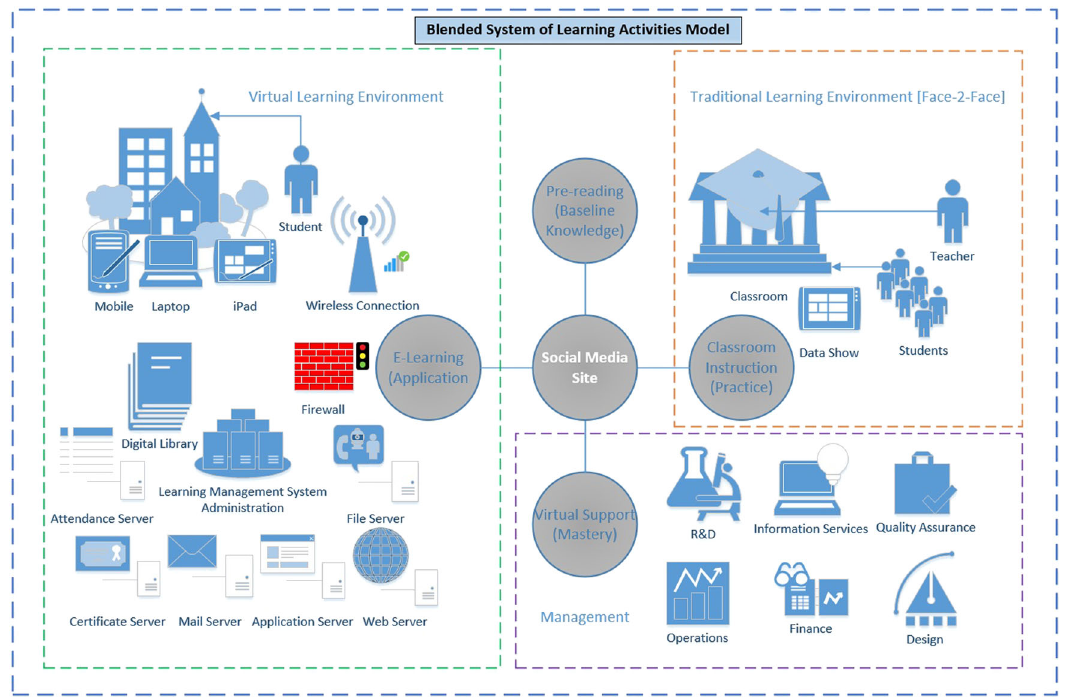
Fig. 2 Blended system of learning activities